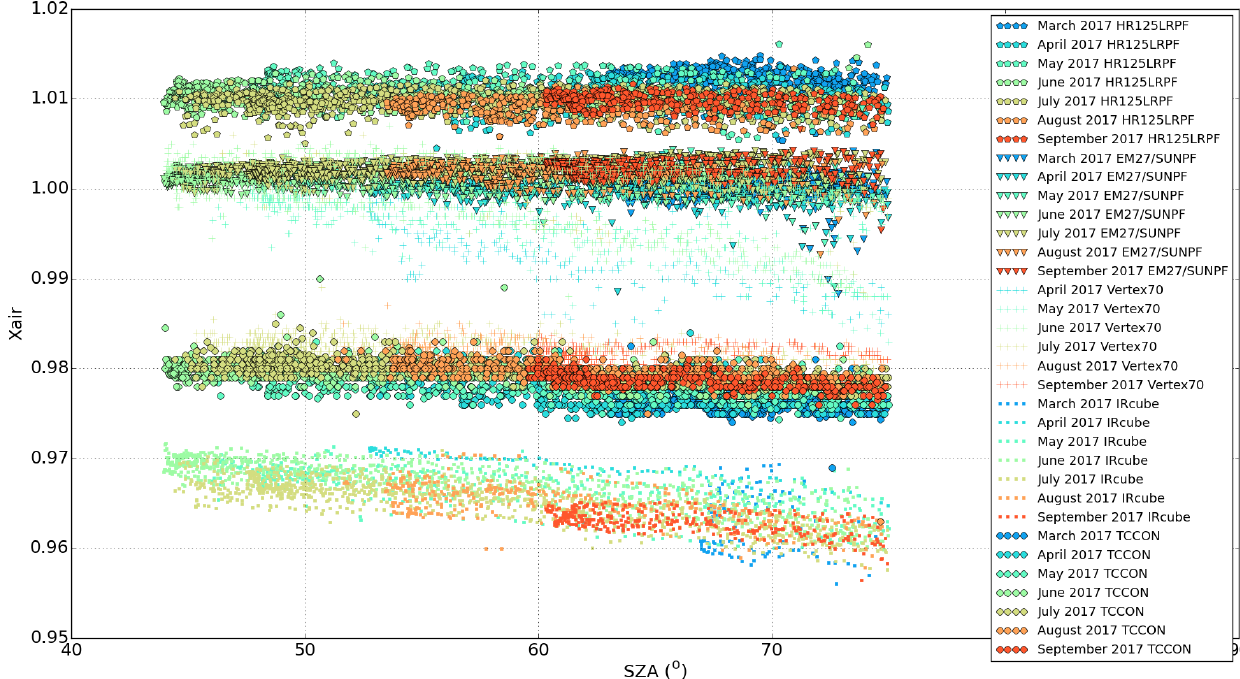
Figure E5. Xair plotted for HR125LR, EM27/SUN, Vertex70, IRcube, and TCCON with respect to the measurement solar zenith angle. The colours represent the measurement performed during the different months of the